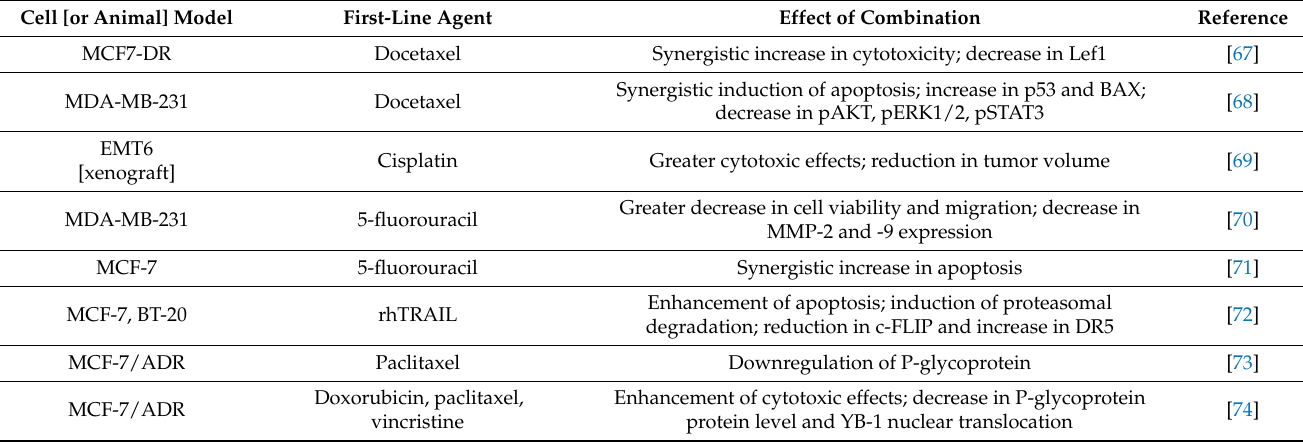
Table 2. Effects of co-administration of quercetin with first-line chemotherapeutic agents in BC experimental